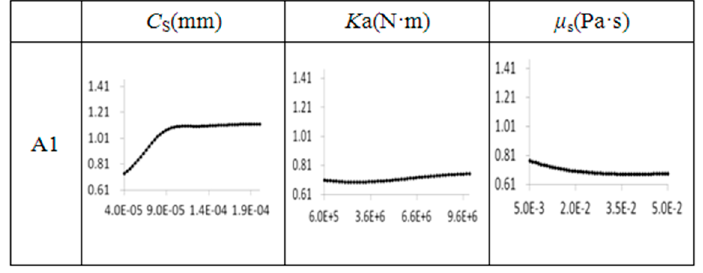
Figure 8. E ff ects of SFD design parameters on the amplitude of the fundamental frequency of the normal system.